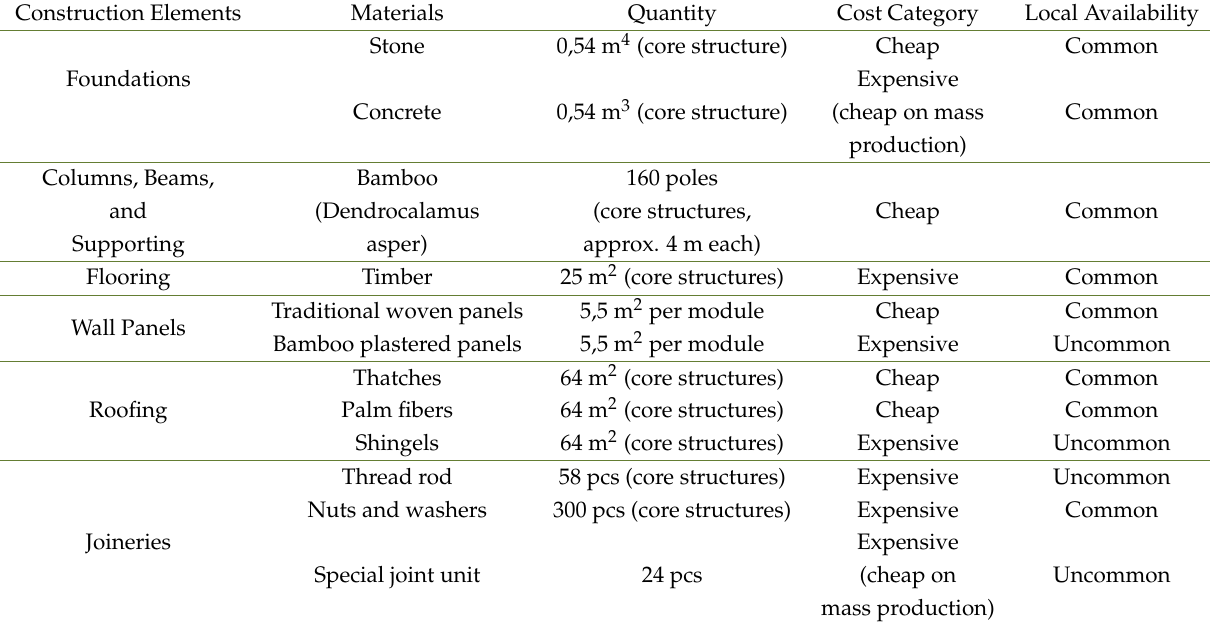
Table 1. Material Options and Specification.